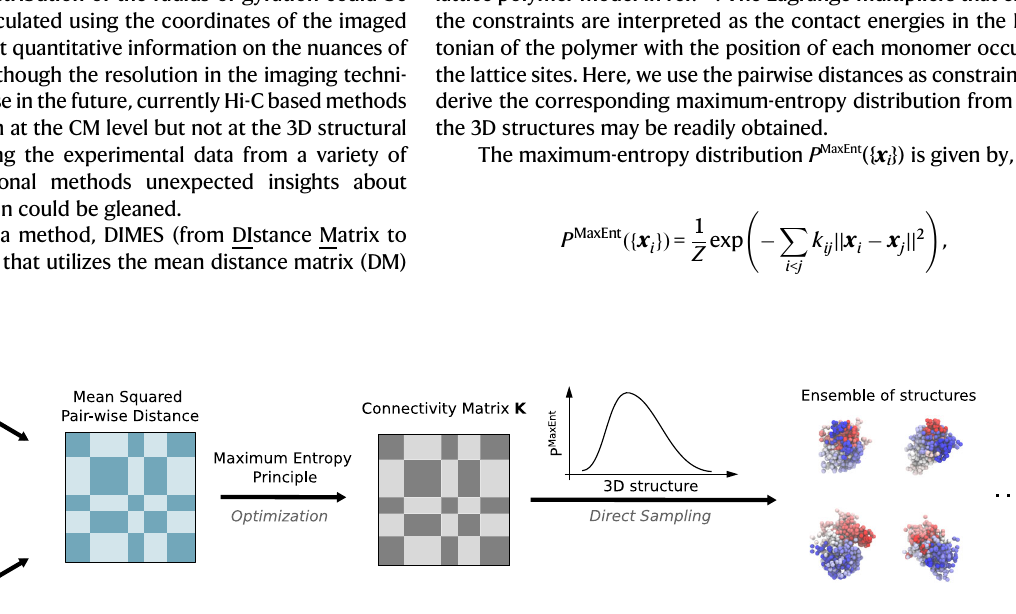
connectivity matrix K , in the P MaxEnt , are obtained through an optimization proce- dureusingeitheriterativescalingorgradientdescentalgorithm,asexplainedinthe “ Methods ” and Supplementary Note 1. The ensemble of structures (coordinates of chromatin loci) can be randomly sampled from the distribution P MaxEnt